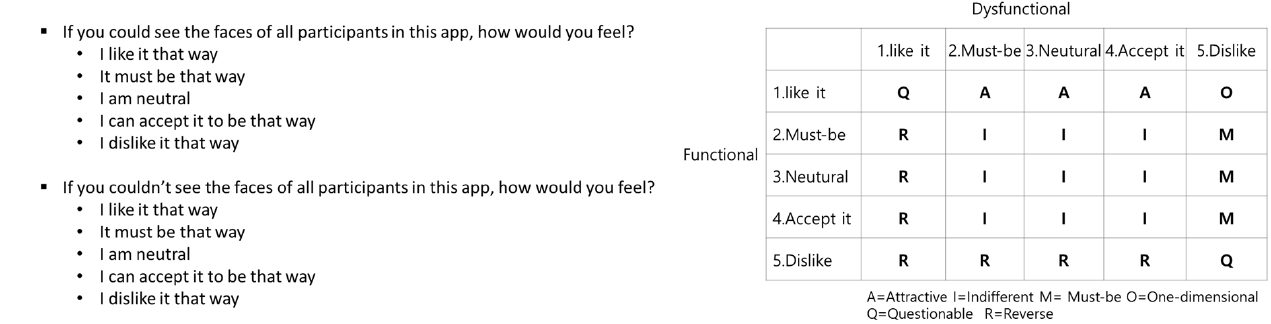
Figure 5. Example questions and possible answers from the Kano questionnaire.